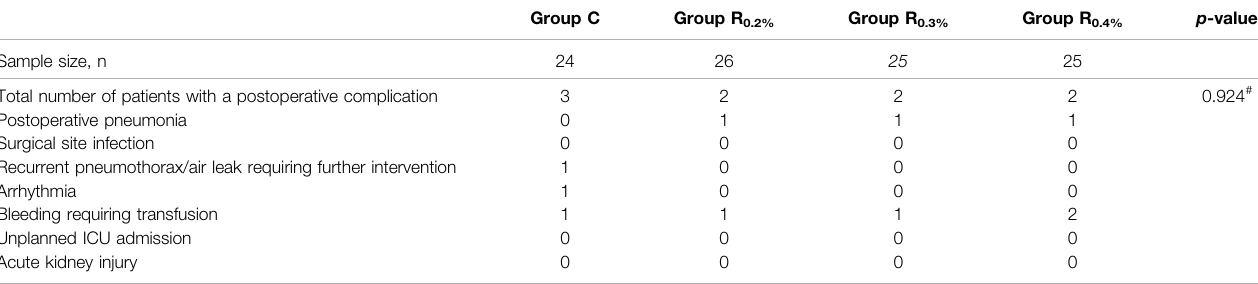
TABLE 5 | Postoperative complications in four groups ( (cid:1) x ±